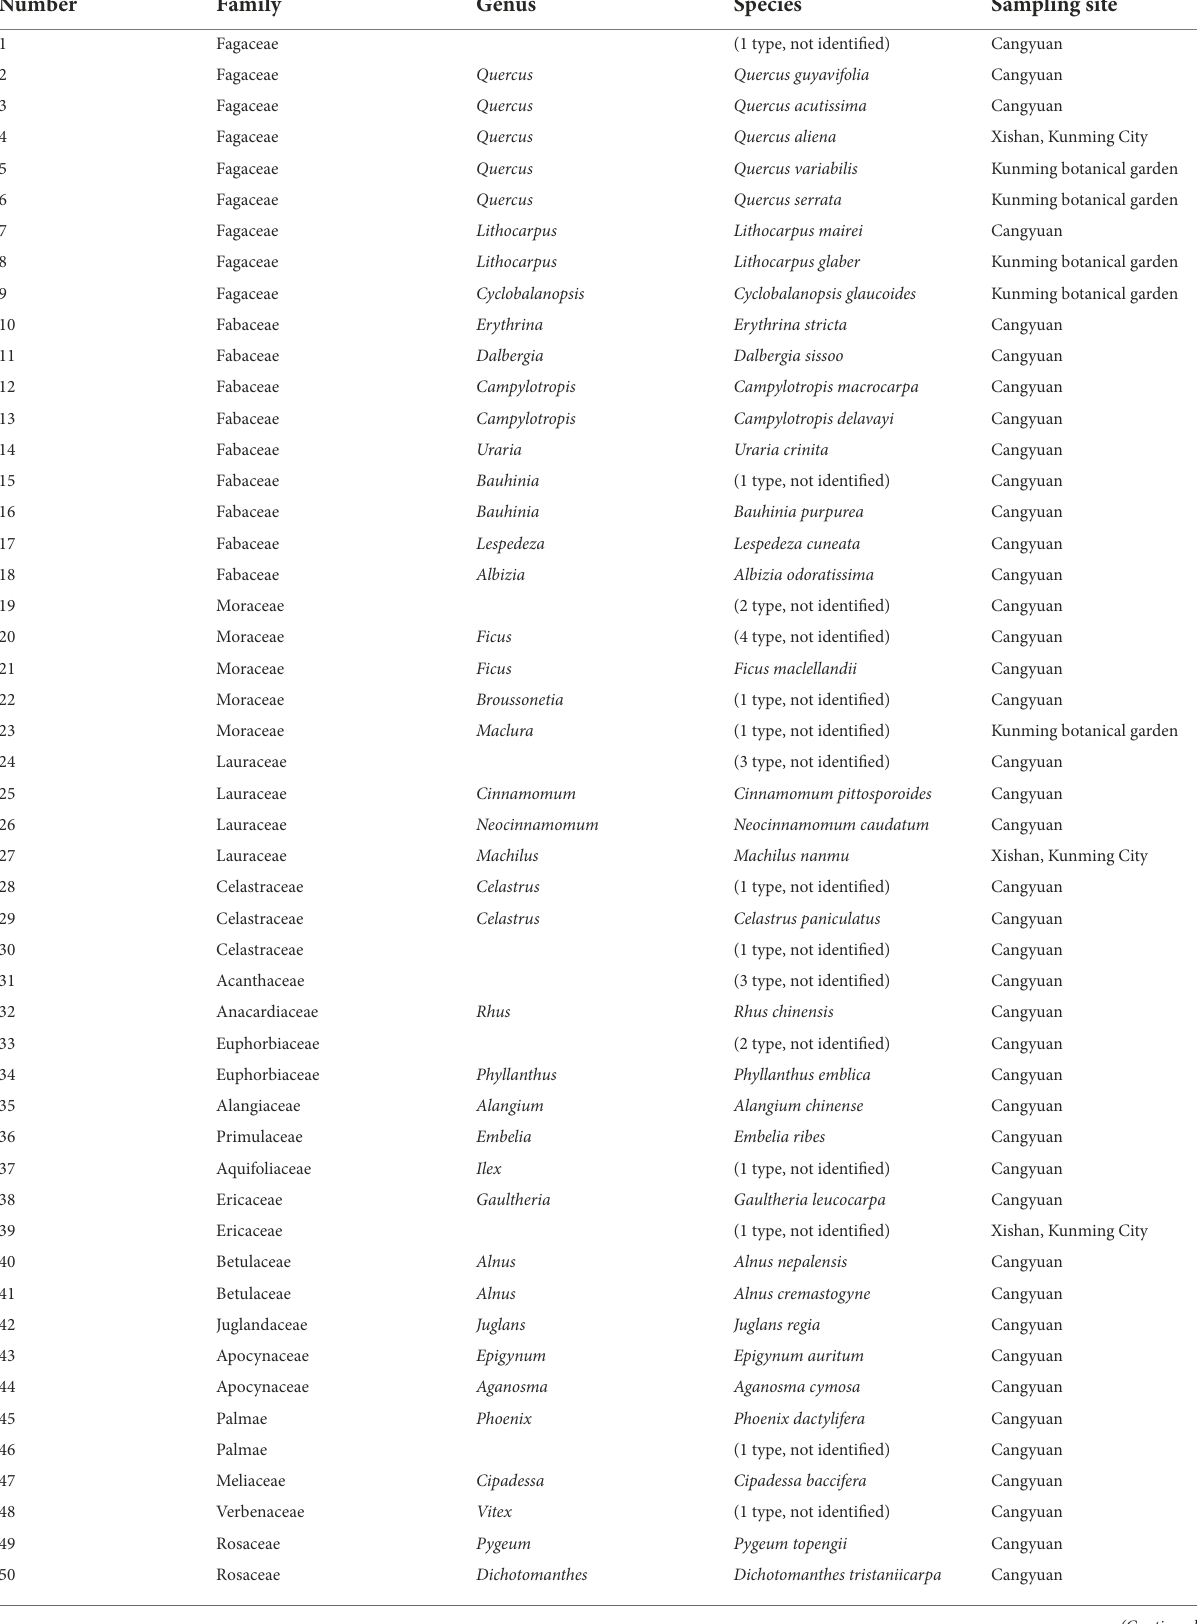
TABLE 1 Plant samples used in the